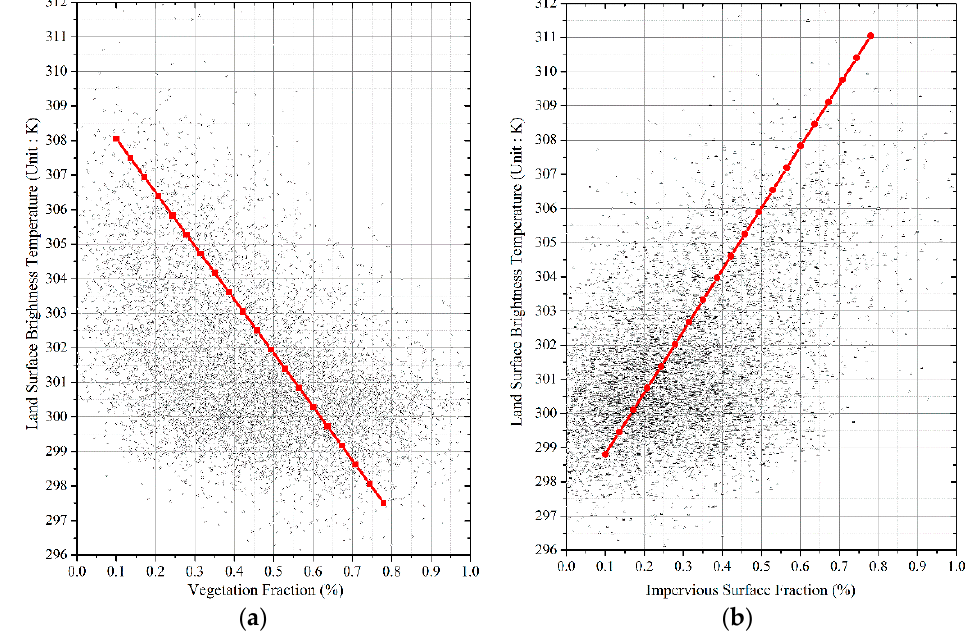
Figure 10. Scatter diagrams of the land surface brightness temperature and the endmember fraction. ( a ) Vegetation fraction; ( b ) impervious surface fraction.